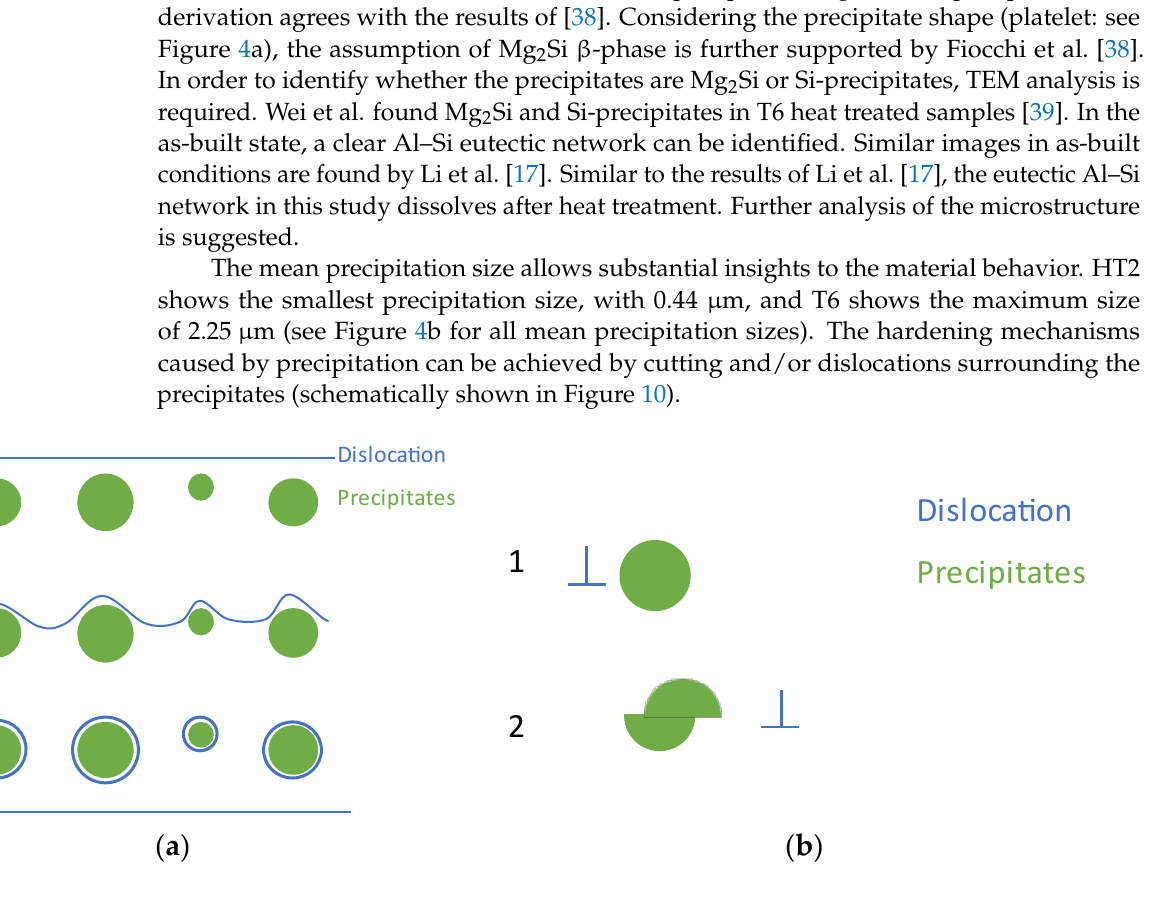
Figure 11. Schematic illustration of the influence of precipitate sizes on cutting or circulating a pre- cipitation in the matrix material, reproduced and adjusted from [40]. T6 shows the largest precipitate size, with 2.25 µm, and a higher strength and higher hardness, tensile and bending strength, with a reduced ductility, see Figures 5–7 and 9 and Table 3. The mechanical properties (hardness, compression, bending and tensile strength) for HT2 samples (see Figures 5–7 and 9 and Table 3) show an increase in ductility but a significant reduction in strength. The images of the samples after compression test- ing showed brittle fracture for T6 and a large amount of deformation for HT2 (shown in Figure 9). This indicates an increase in plasticity in HT2 samples, which is assumed to occur by precipitation cutting processes combined with dislocation movement around the precipitates. Since the cutting of precipitates with dislocations is limited by a critical par- ticle size (see Figure 11), this leads to the assumption that the critical precipitate size of AlSi10Mg is in the range of d pre_HT2 < d pre_crit < d pre_T6 (0.44 µm < d pre_crit < 2.25 µm). In addition to the precipitation strengthening mechanisms, grain refinement should also be considered. The high cooling rate during LPBF [22] leads to a finer microstructure compared to conventional manufacturing technologies. Grain refinement leads to in- creased strength according to the Hall–Petch relation [41]. Since the amount of solid